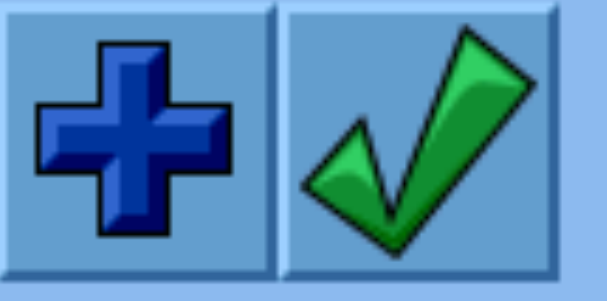
Figure 1 Buttons for selecting and adding